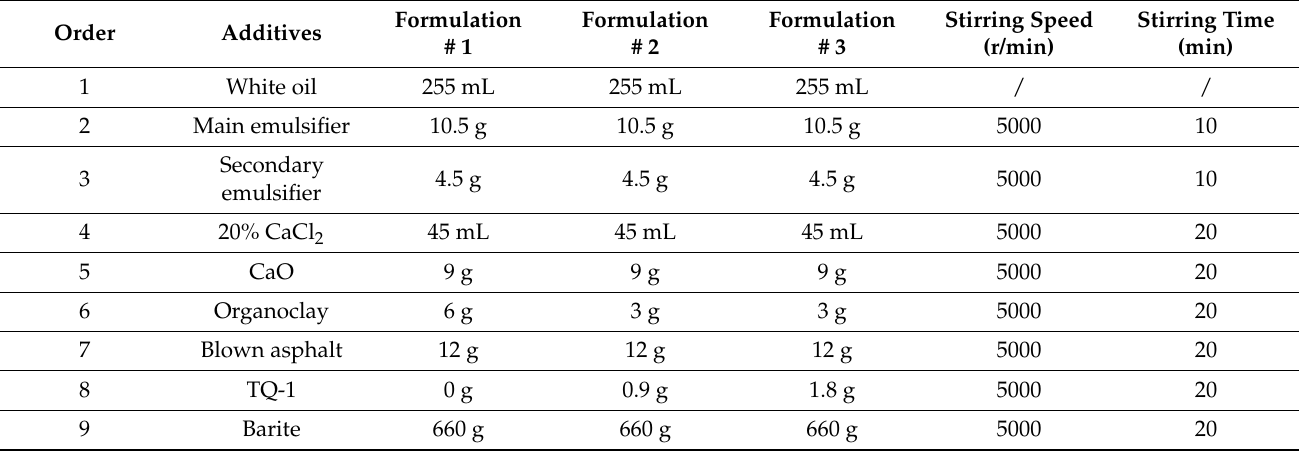
Table 2. Preparation method of the